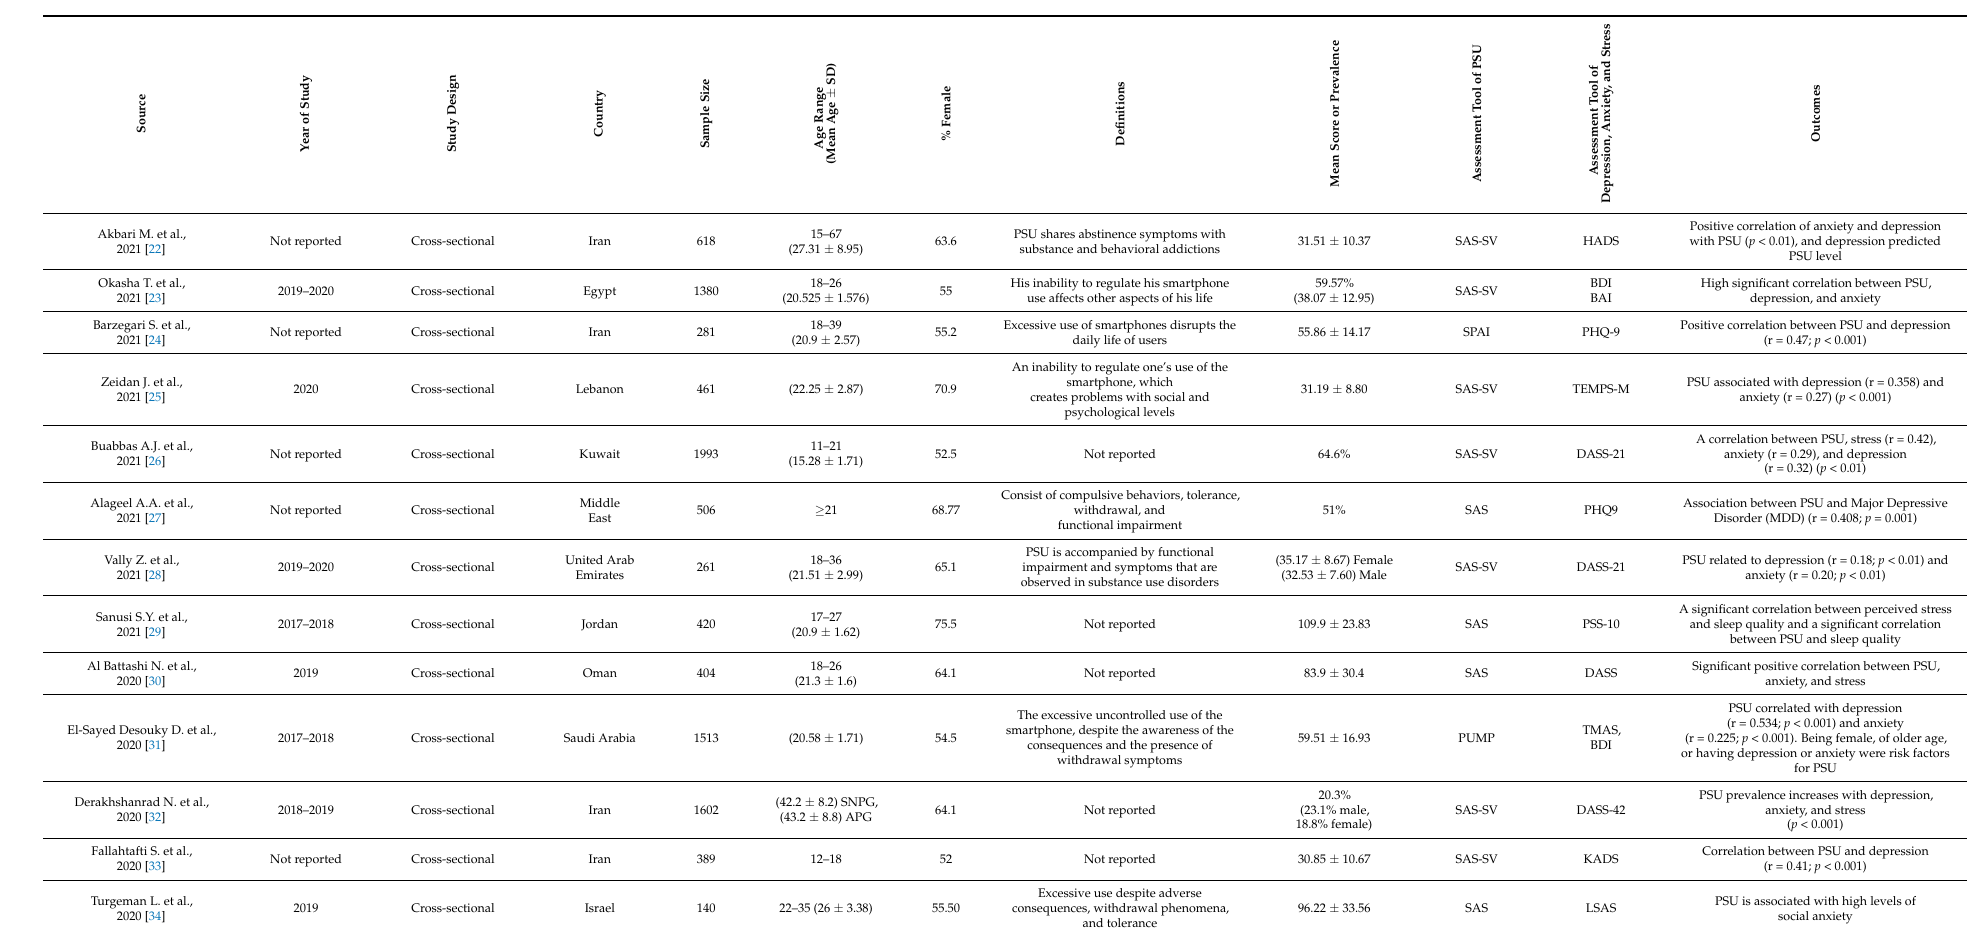
Table 1. Main results of included